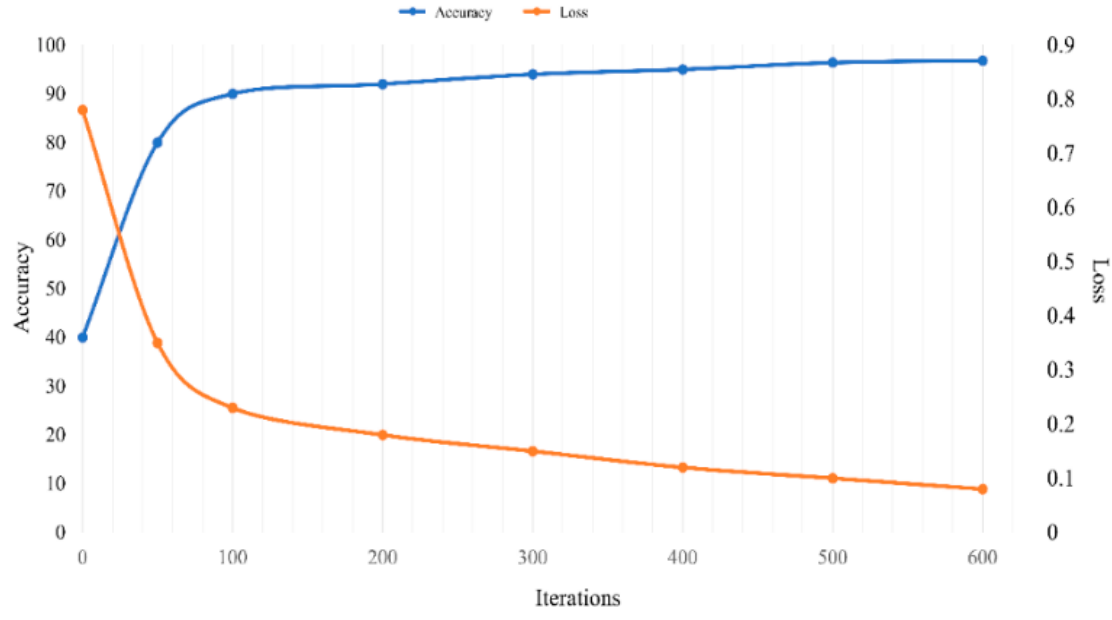
Figure 3. Value of validation accuracy and loss as a function of epochs.